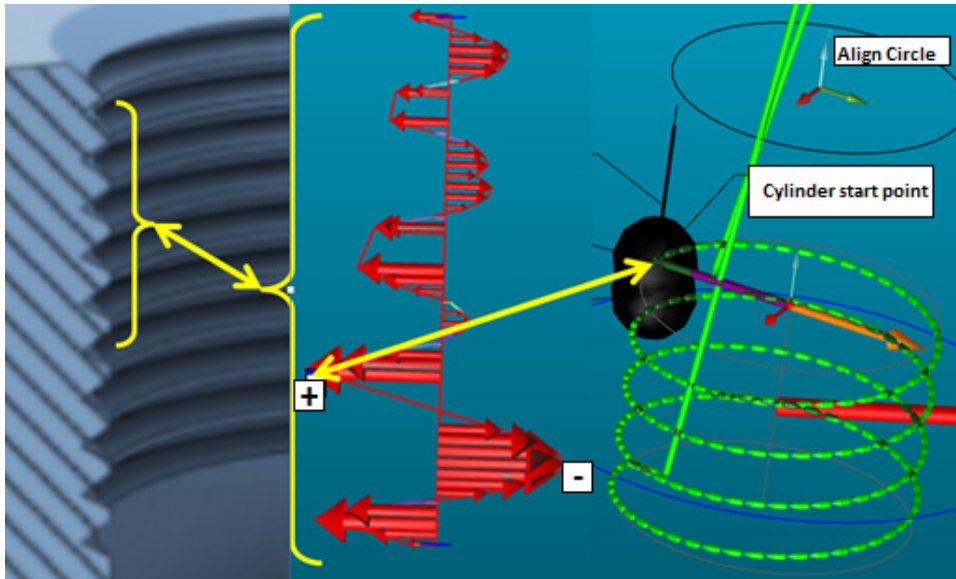
Figure 1. Evaluation steps to measure the inner thread.